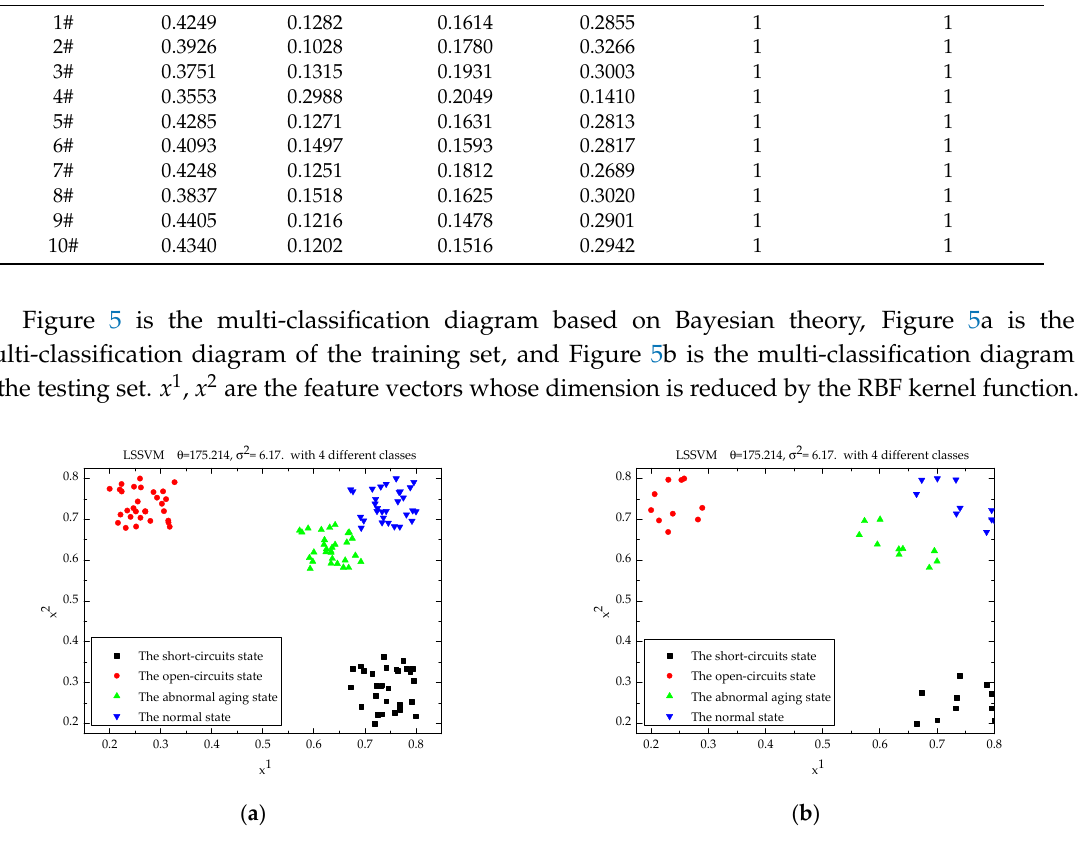
Figure 5. The multi-classification diagram. ( a ) the multi-classification diagram of the training set; ( b )the multi-classification diagram of the testing set.